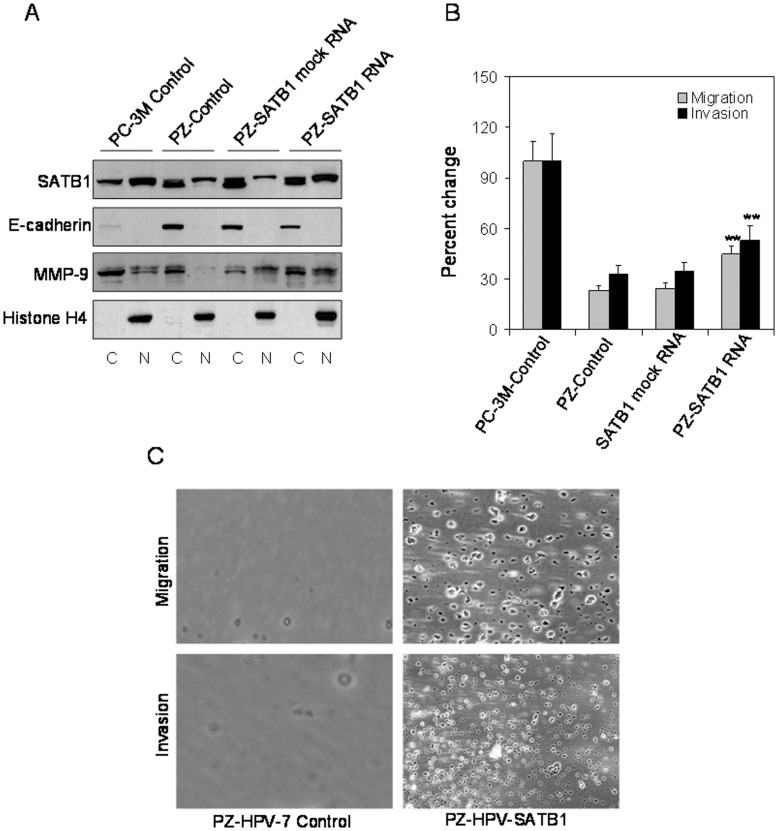
Overexpression of SATB1 in transformed normal prostate epithelial PZ-HPV-7 cells.PZ-HPV-7 cells were transfected with and without DNA (mock), or the SATB1-targeted vector 1 and continued in culture for 24 h. (A) SATB1, E-cadherin, MMP9 and Histone H4 protein expressions were determined in the cytosolic and nuclear fraction by Western blotting. SATB1 overexpression resulted in decrease E-cadherin expression and upregulated MMP9 expression. (B) Overexpression of SATB1 in PZ-HPV-7 cells was associated with increased invasive potential. Bars represents the mean±SE of three different assays. **P<0.001 versus control. (C) Representative PZ-HPV-7 images with and without SATB1 overexpression vector trasfection. Details are described in ‘materials and methods’ section.